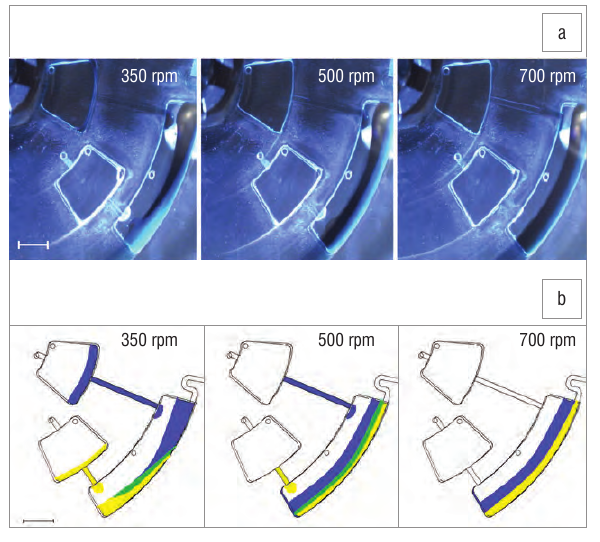
The microfluidic disc at various spin speeds to illustrate sedimentation of fluids: (a) images of the disc device captured using the experimental set-up and (b) corresponding sketches to illustrate the fluid interactions for each of the images in (a).